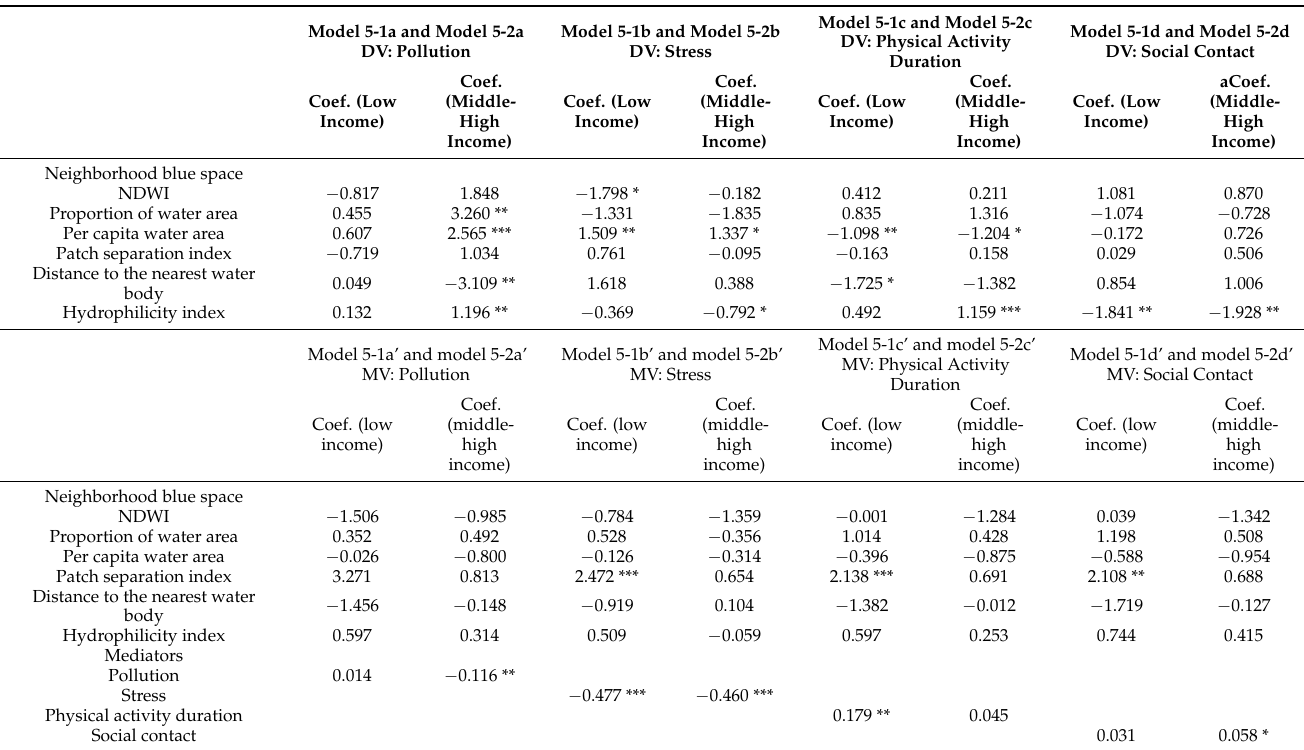
Table 8. Associations between neighborhood blue space, mediators, and SRH in income